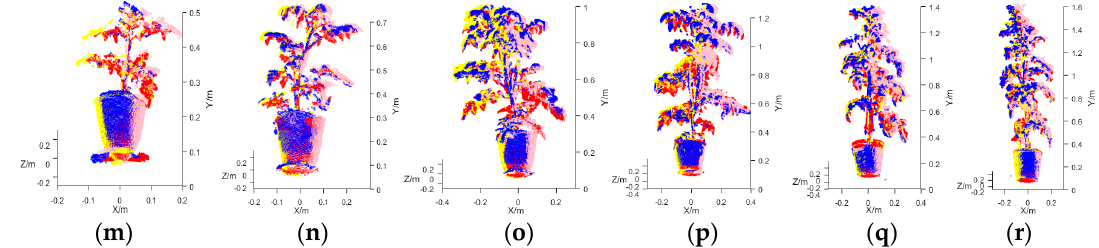
Figure 12. 3D point cloud reconstruction maps of GTPs: ( a ) T9 point cloud; ( b ) T25 point cloud; ( c ) T29 point cloud; ( d ) T31 point cloud; ( e ) T48 point cloud; ( f ) T56 point cloud; ( g ) T9 (V3-1); ( h ) T25 (V3-1);